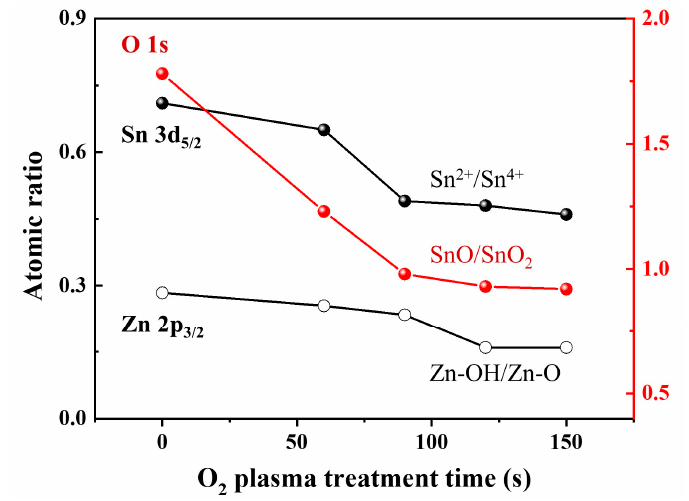
Figure 5. The atomic ratios of the deconvoluted components in the XPS peaks for Sn 2+ /Sn 4+ , SnO/SnO 2 , and Zn–OH/Zn–O as a function of O 2 plasma treatment time.